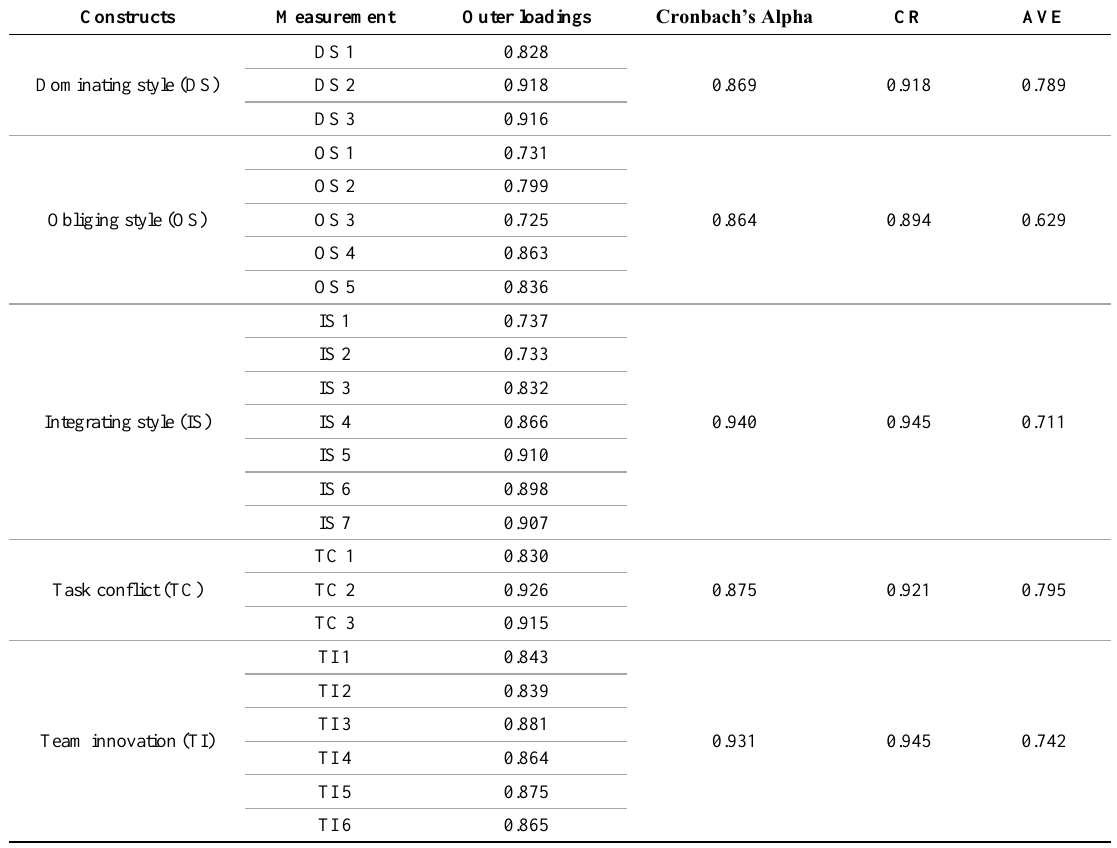
Table 4. Outer loadings, AVE, CR, and Cronbach’s Alpha.